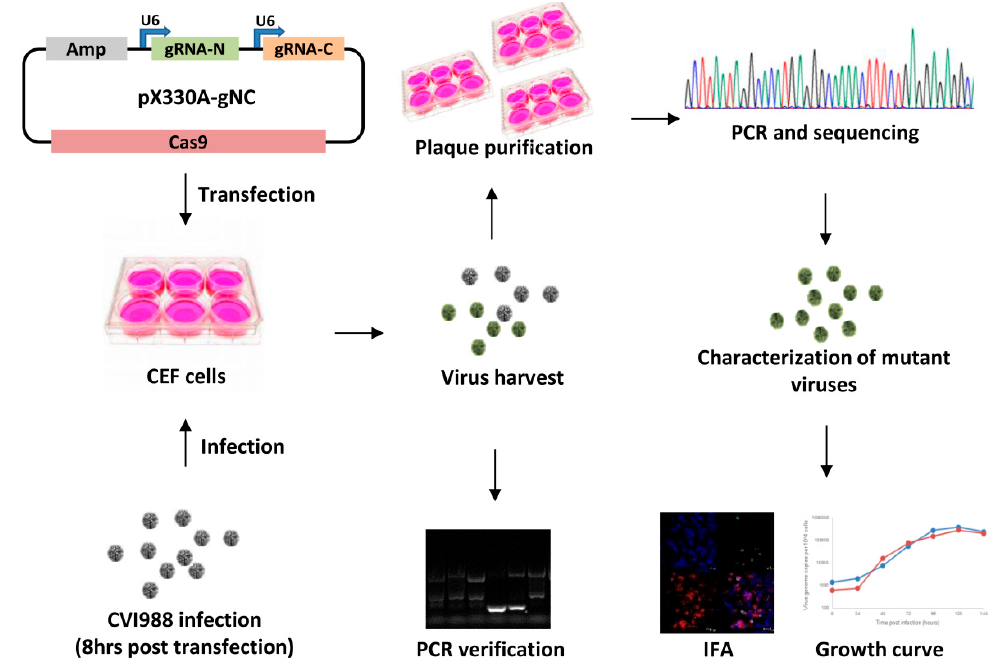
Figure 1. A diagram depicting the protocol used to generate mutant viruses. The gRNA/Cas9 expression plasmid for targeting the gene of interest was transfected into CEF and followed by CVI988 virus infection. The transfected/infected cells were harvested followed by PCR and plaque purification. The purified plaques were then verified by PCR and sequencing. The verified virus was characterized by IFA and growth kinetics studies.